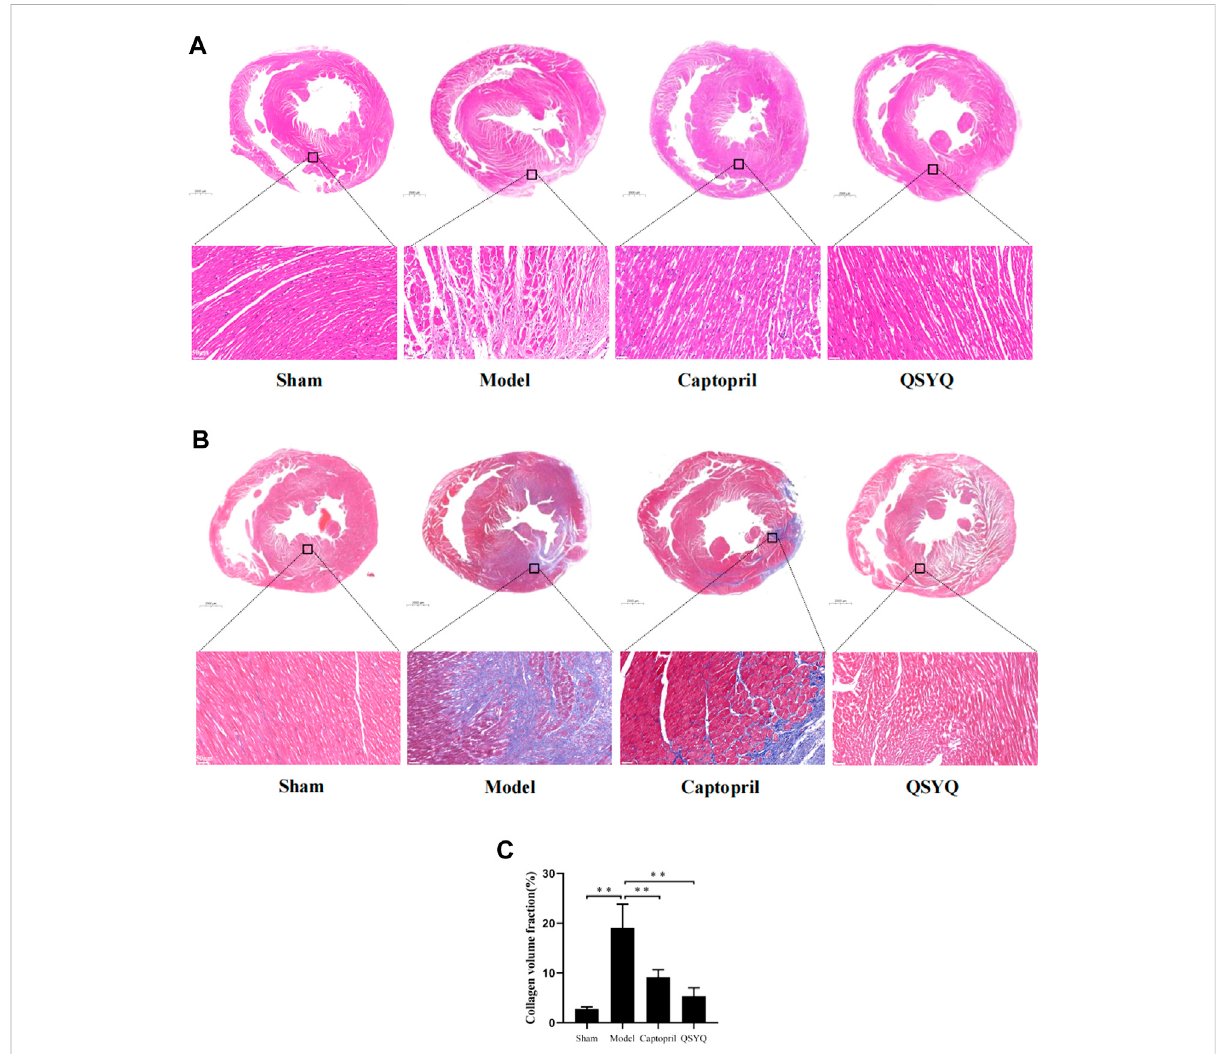
FIGURE 8 Effect of QSYQ on pathological morphology and collagen deposition of myocardium. (A) : HE staining showed that in model group myocardial fi bers were disordered, and appeared swelling, fracture, degeneration and necrosis, accompanied by extensive in fl ammatory in fi ltration. Compared with model group, the morphology of myocardial tissue was improved in both the captopril and QSYQ groups. The myocardial fi bers were well arranged,andswellingandin fl ammatoryin fi ltrationofmyocardialinterstitiumweresigni fi cantlyalleviated, n =4pergroup. (B) :Massonstaining of myocardial tissue showed that in model group the myocardial fi bers arrangeddisorderly. There was a large amount of blue-stained collagen fi ber deposition in the myocardial interstitial, and the fi brosis was more obvious at the edge of infarction. The CVF was signi fi cantly increased in model group. Compared with the model group, the CVF was decreased in both of the captopril and QSYQ groups. (C) : Quantitative analysis of QSYQ on CVF, n = 4 per group. Data are expressed as mean ± SD. ** p <